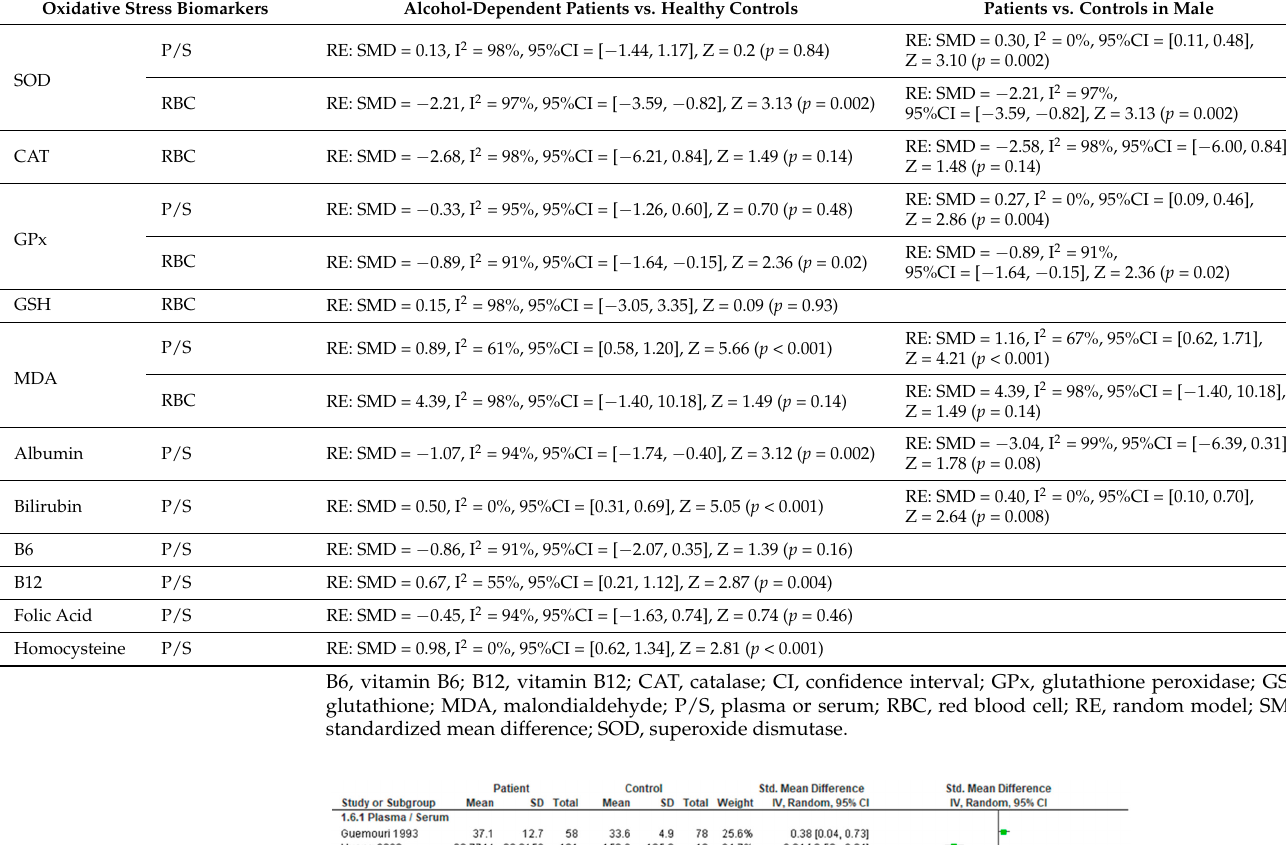
Table 3. The effect sizes of oxidative biomarker between alcohol-dependent patients and healthy controls. Oxidative Stress Biomarkers Alcohol-Dependent Patients vs. Healthy Controls Patients vs. Controls in Male